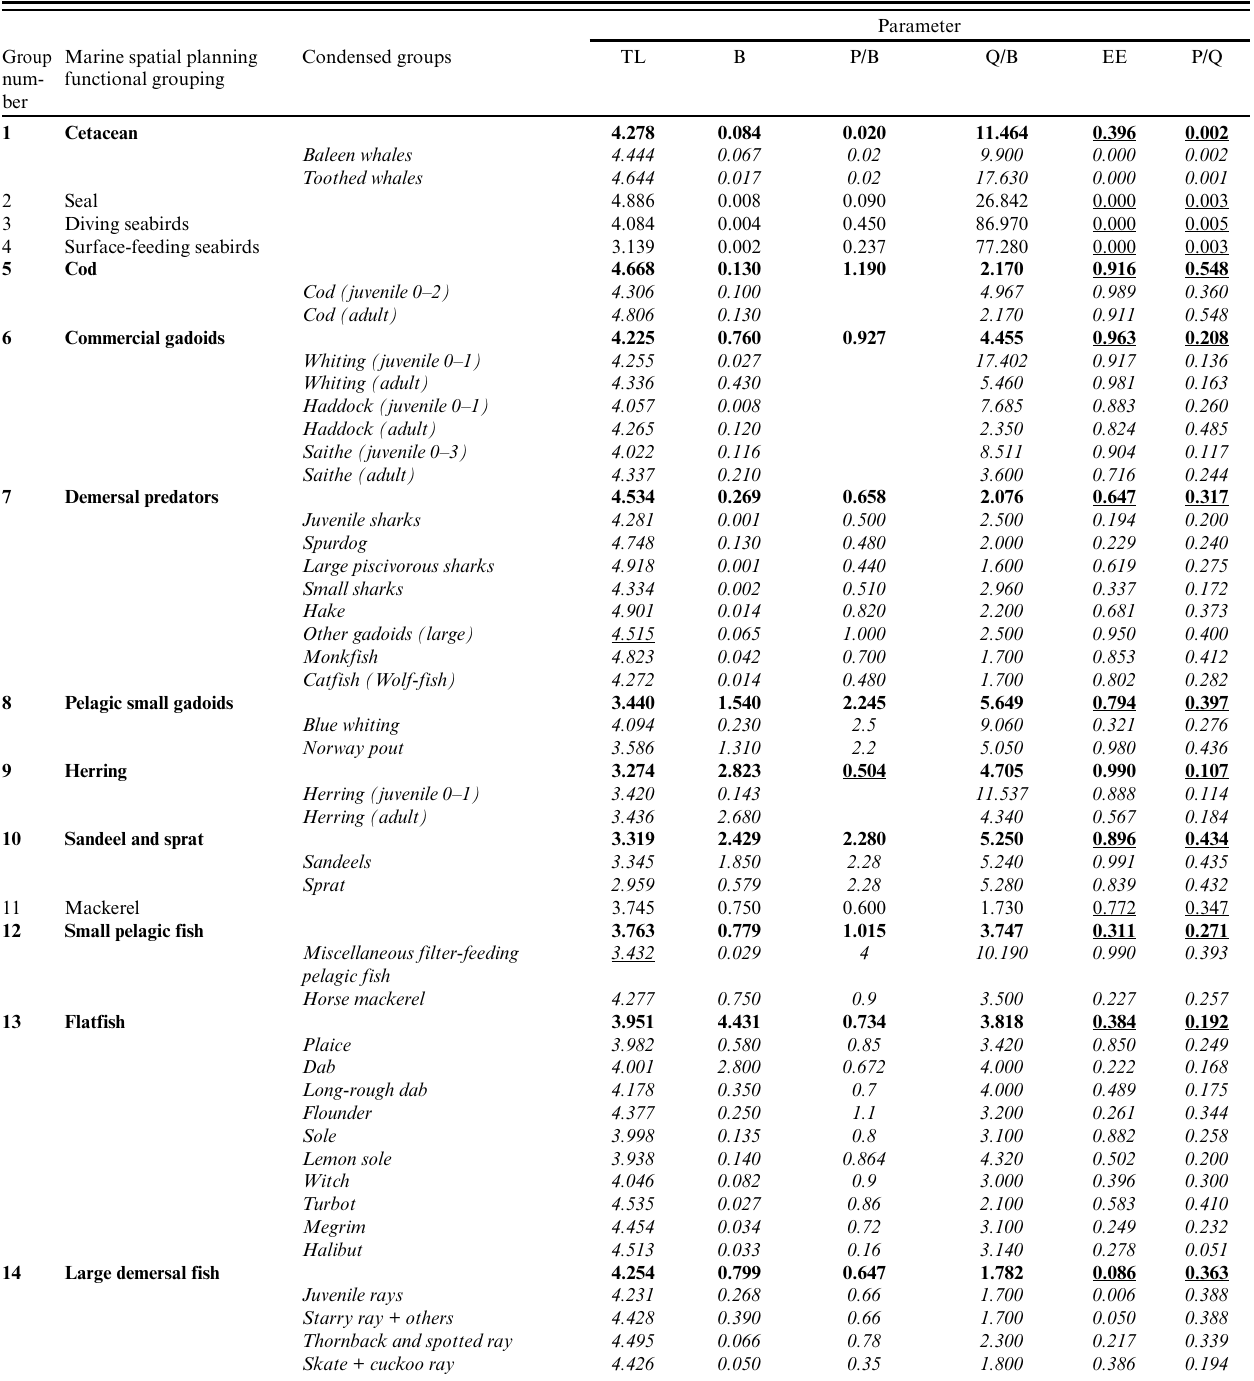
Table 2. Basic inputs for the condensed and balanced marine spatial planning challenge North Sea Ecopath model.